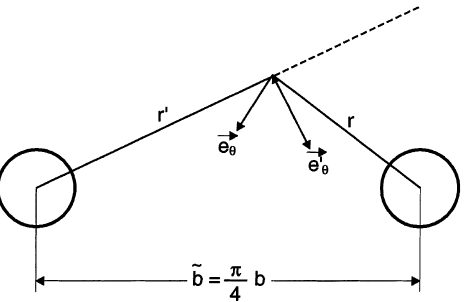
Fig. 2. Wake vortex as a superposition of two